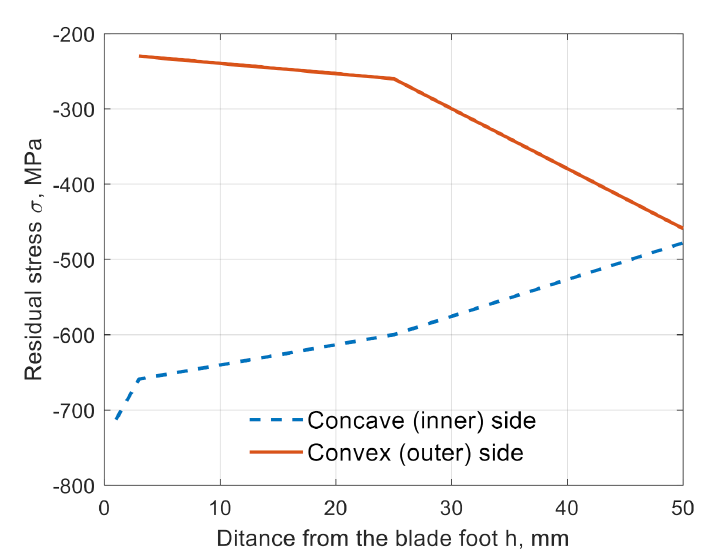
Figure 5. Distribution of initial stresses in the surface layer along with the height of the blade. In addition to the measurement along with the blade height, the residual stresses were measured in a cross-section of 3 mm from the blade root. The measurement was made at six points–three on the inner and three on the outer side of the blade. The exact location of the measurement points is presented in Figure 6, and the measurement results are presented in Table